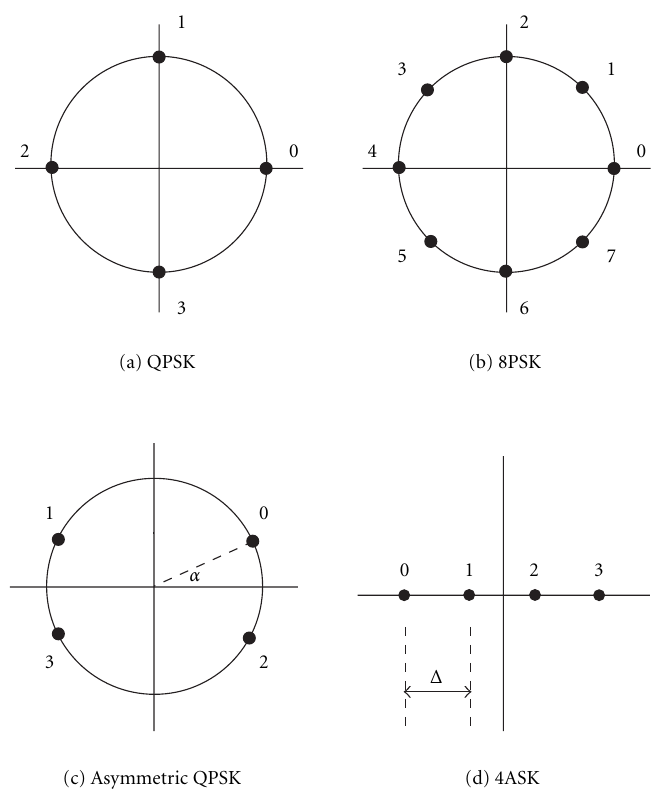
Figure 4: Example